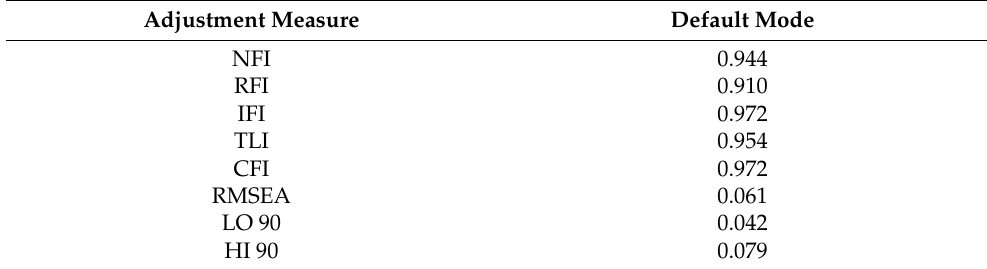
Table 8. Confirmatory factor analysis. Model adjustment measures.